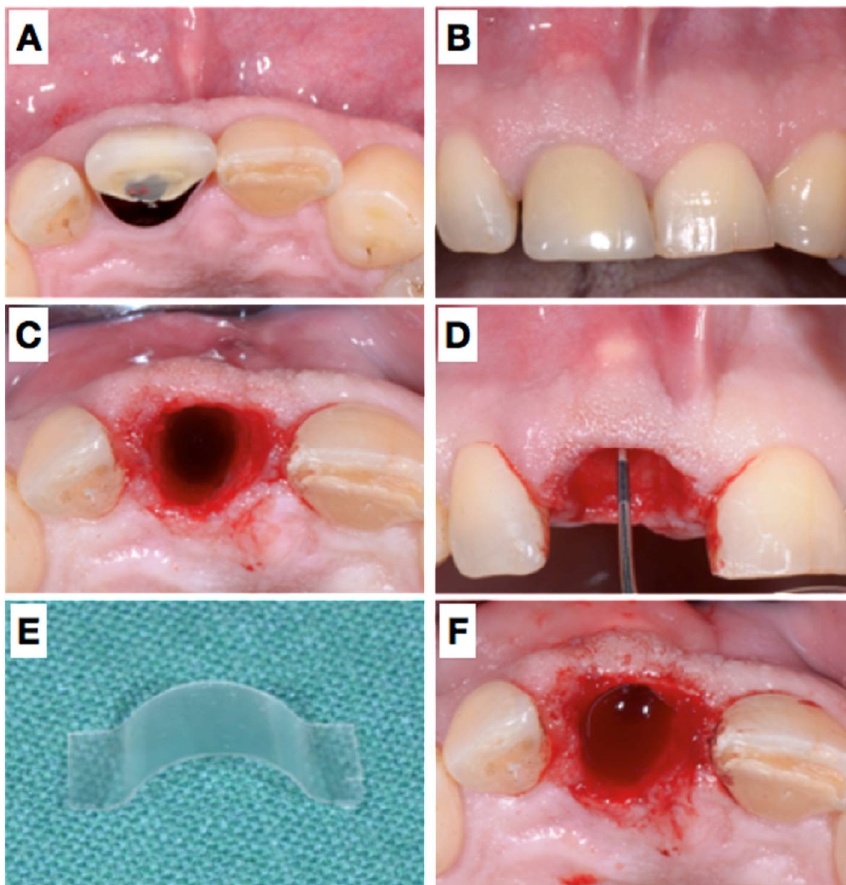
Figure 1. Pre-operative view of the tooth 11 still in situ ( A , B ) and after extraction ( C ). Panel ( D ) shows clinically the lack of the buccal plate elucidated with the periodontal probe causing local blood circulation impairment due to pressure at the respective apical gingiva. A resorbable rigid membrane was cut in shape ( E ) and placed under the resorbable collagen membrane ( F ), unfortunately not clearly visible in the image).